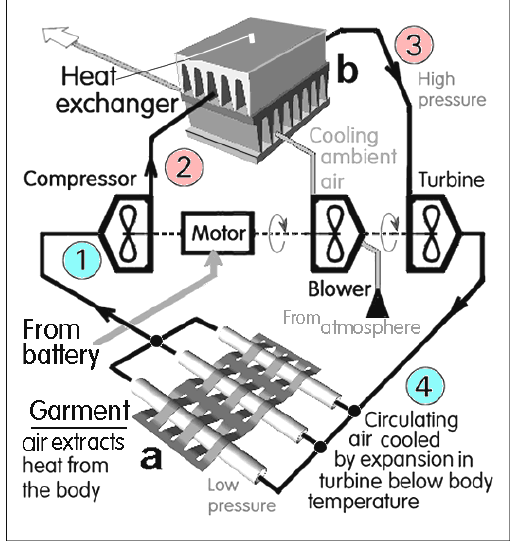
Fig. 2. Schematic presentation of the cooling garment idea as under development so far [1]. The air flow after expansion from (3) to (4) is fed into the tubes in the textile a where it removes heat from the garment wearer’s body . The air temperature is then increased by compression (1) to (2), making possible removal of heat from the air in the exchanger b.